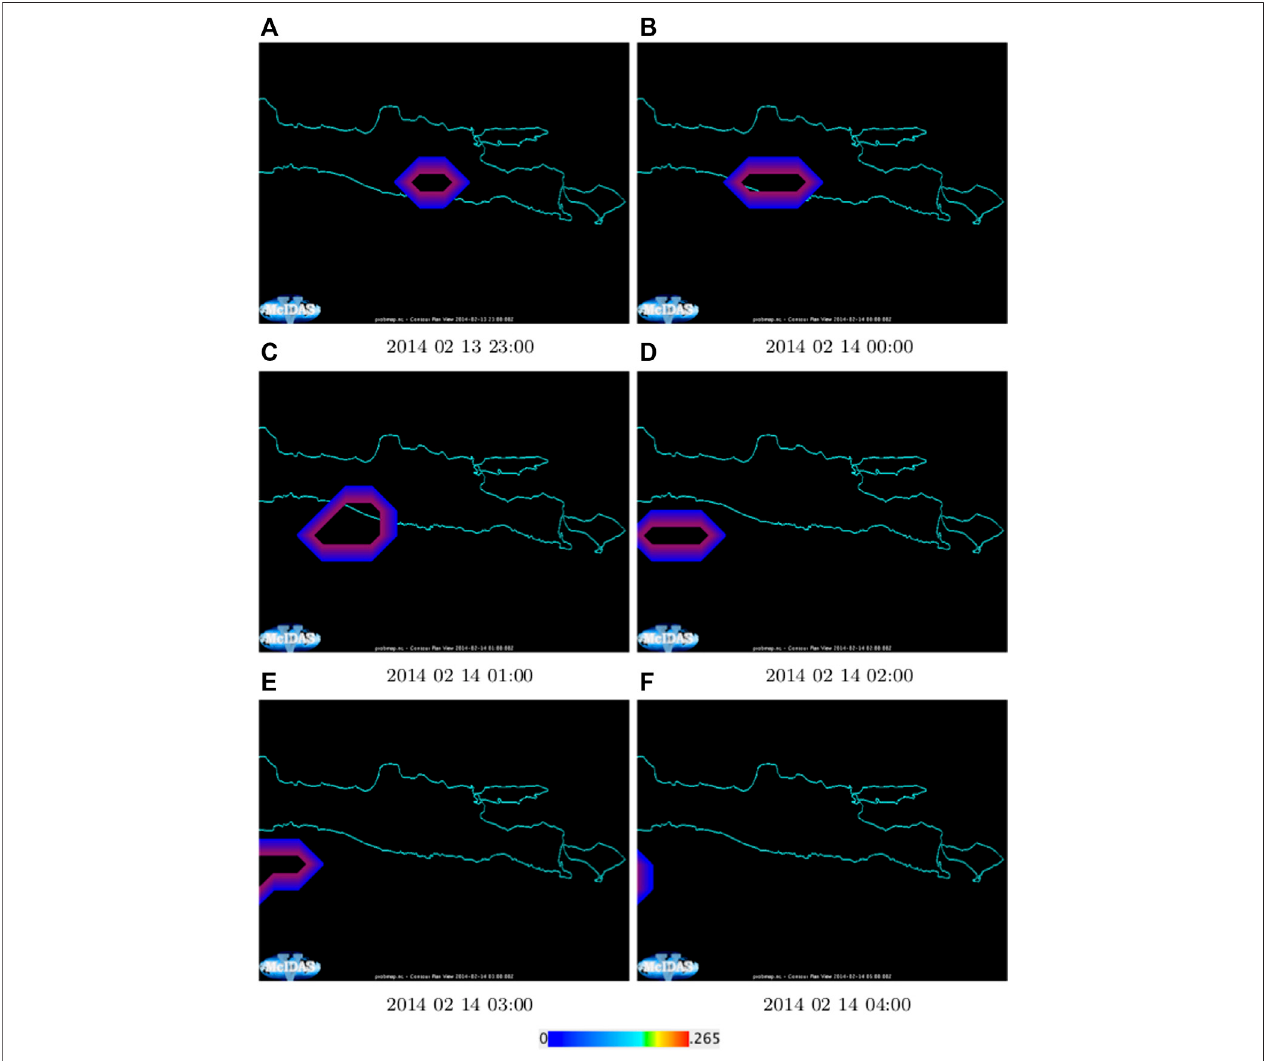
FIGURE 13 | (A – F) Conditional probability of ash at height c. 17 km for 6 h following the Kelut volcano eruption February 13, 2014. Plots were created with a low resolution grid. Higher resolution grids may be used via the tool ’ s Select Meteo Data File input option.